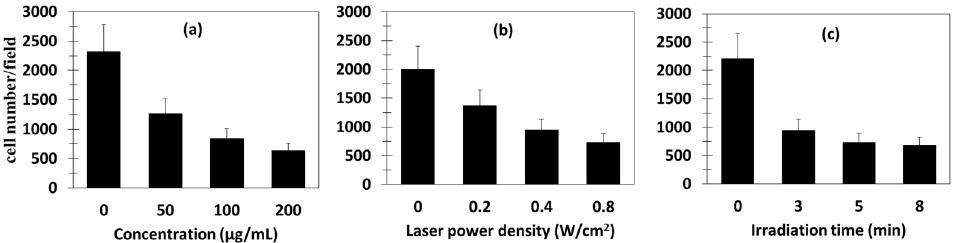
Figure 7. In vitro PDT of Er@Nd-RB. Cell viability of 4T1 cells with different ( a ) concentrations, ( b ) laser power densities, and ( c ) irradiation times. Adapted from Li et al. [25].